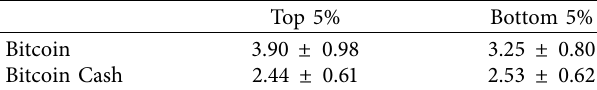
Table 6: Power-law exponent.